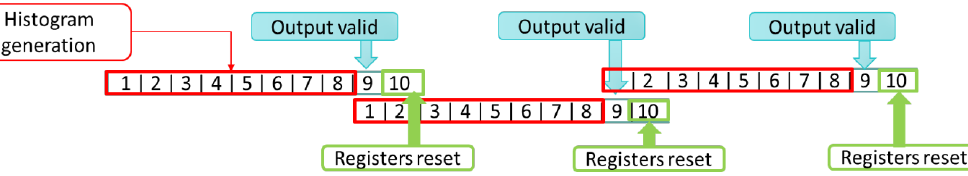
Figure 10. The time-sharing protocol for the histogram generation module.